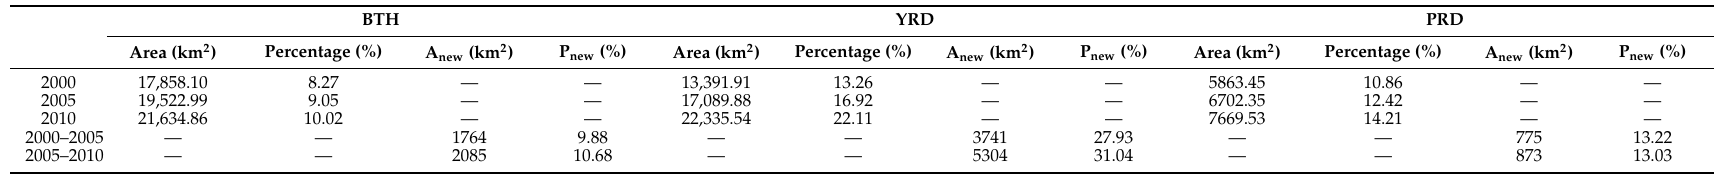
Table 3. The total area and proportional cover of developed land, and area of newly developed land (A new ) and its ratio to the previously existing developed land (P new ) in three urban megaregions.